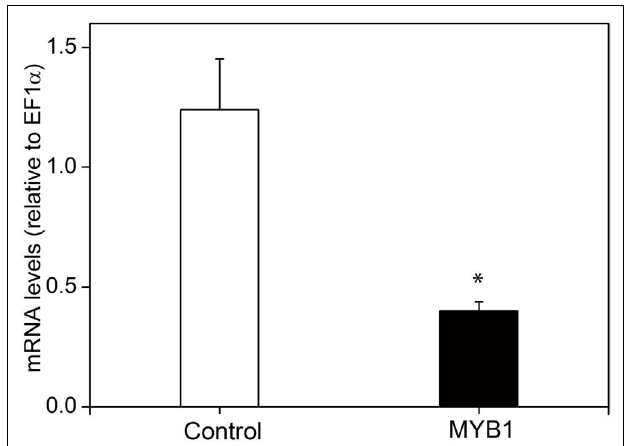
FIGUREA3 | Expression analysis of PpAS1 in maritime pine protoplasts. Internal levels of PpAS1 were determined by real-time qPCR in electroporated protoplasts in the absence or the presence of the effector construct containing PtMYB1. See the legend of Figure 7 for further details. Bars indicate the standard errors of three independent experiments. A Student’s t -test was performed to determine the significance ( P < 0.01) of the observed differences.The significant change is marked with an